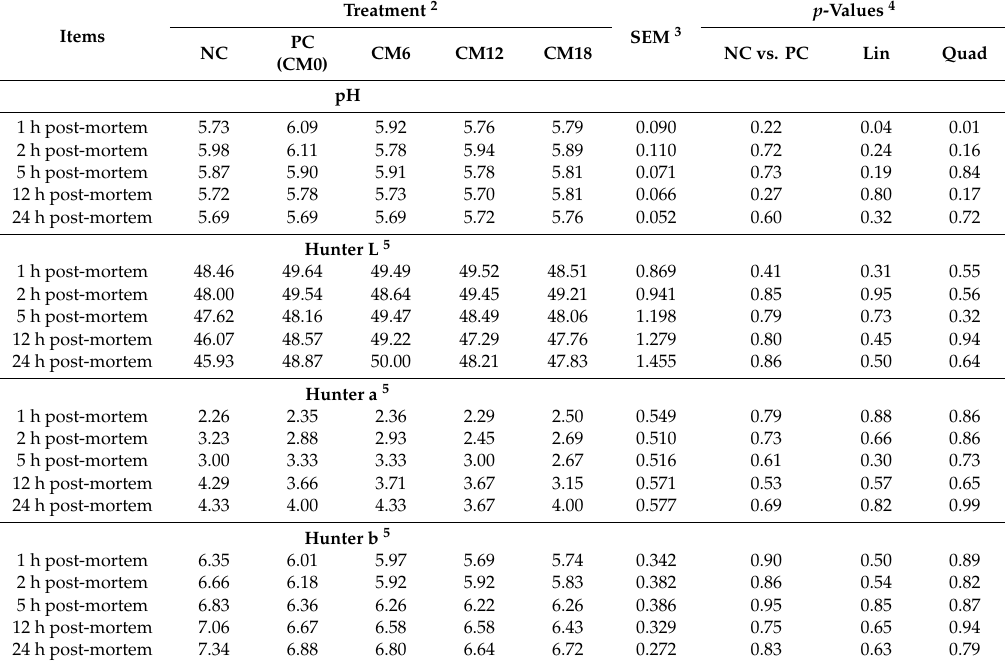
Table 9. E ff ects of copra meal (CM) inclusion level in the diet with β -mannanase on pork loin pH and color